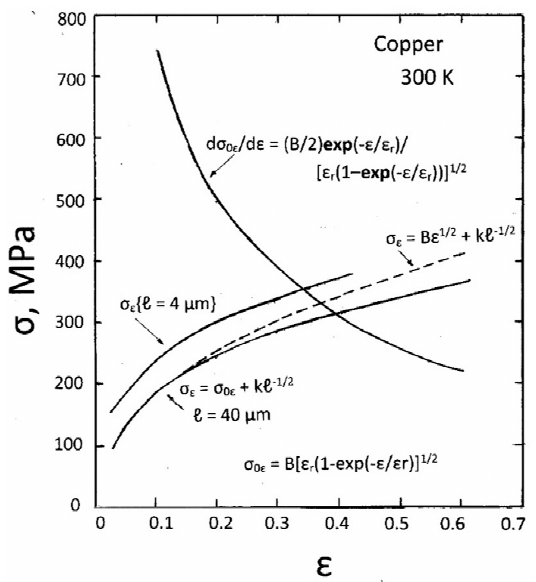
Figure 2. H-P based plastic instability computations demonstrating a decrease in the tensile uniform strain at reduced grain size for copper material.